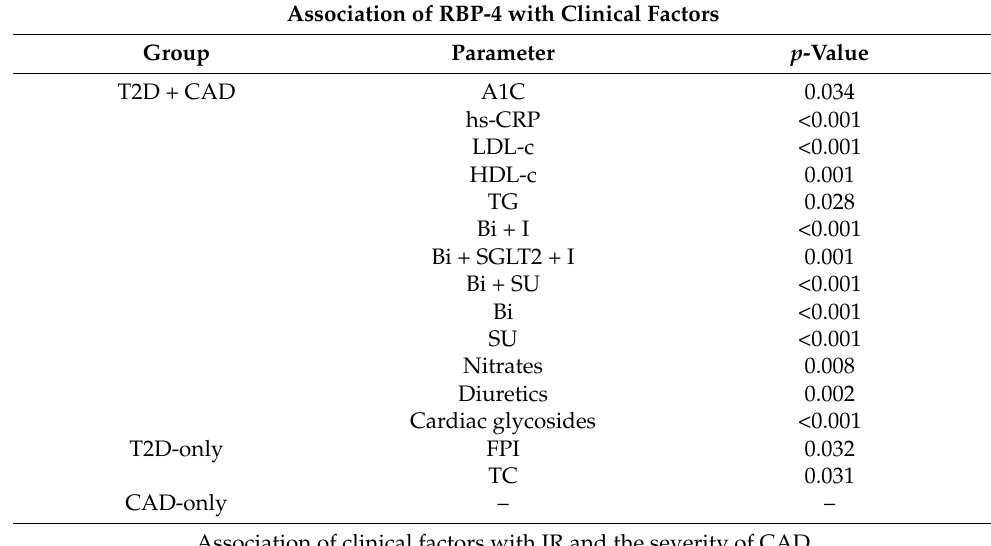
Table A1. Summarization of significant outcomes from preliminary analysis of study ( p <